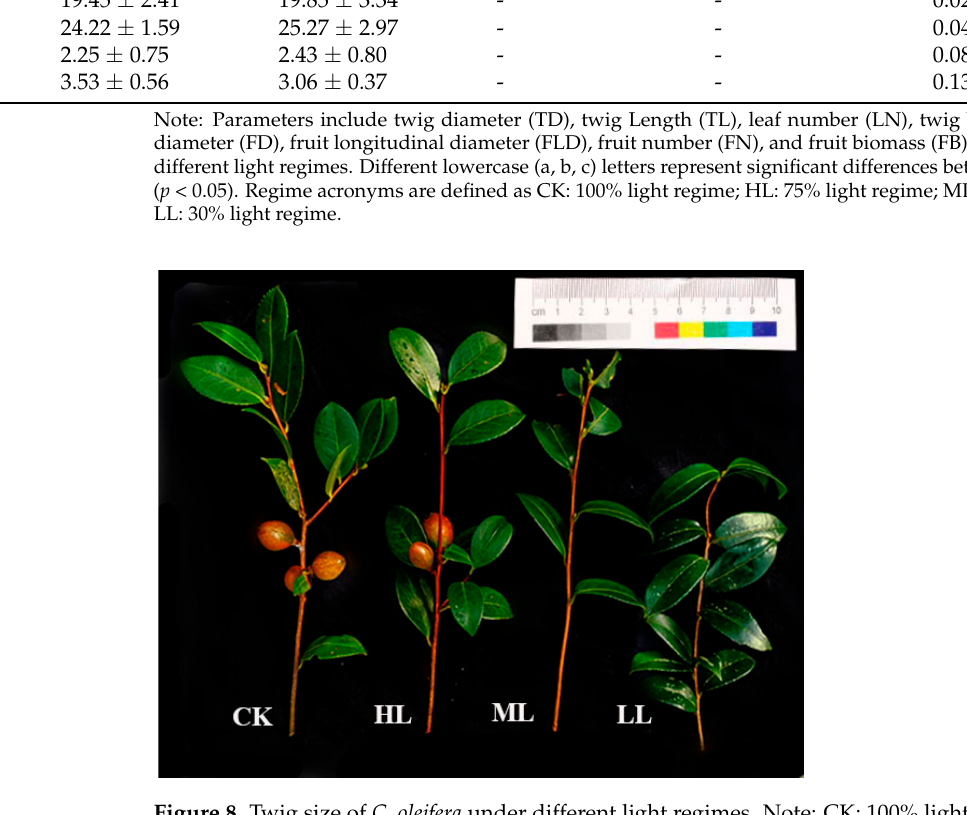
Figure 8. Twig size of C. oleifera under different light regimes. Note: CK: 100% light regime; HL: 75% light regime; ML: 50% light regime; LL: 30% light regime.